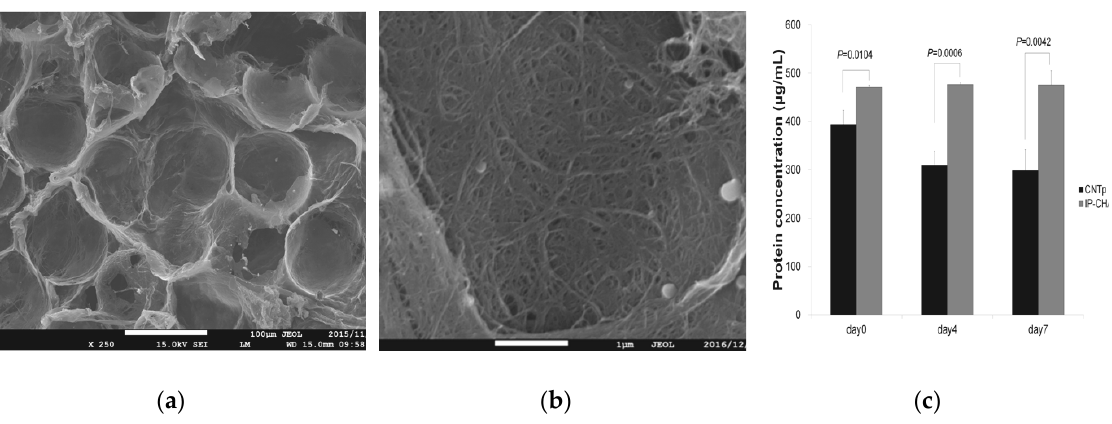
Figure 2. ( a ) Scanning electron microscope (SEM) image of a carbon nanotube porous block (CNTp). Scale bar, 100 µm. ( b ) SEM image of CNTp. Scale bar, 10 µm. ( c ) When a scaffold composed of interconnected porous hydroxyapatite ceramics (IP-CHAs) was immersed in a bovine serum albumin (BSA) solution, more protein was adsorbed to CNTp and the protein concentration in the solution was reduced. Image is modified from a study by Tanaka et al. [51].